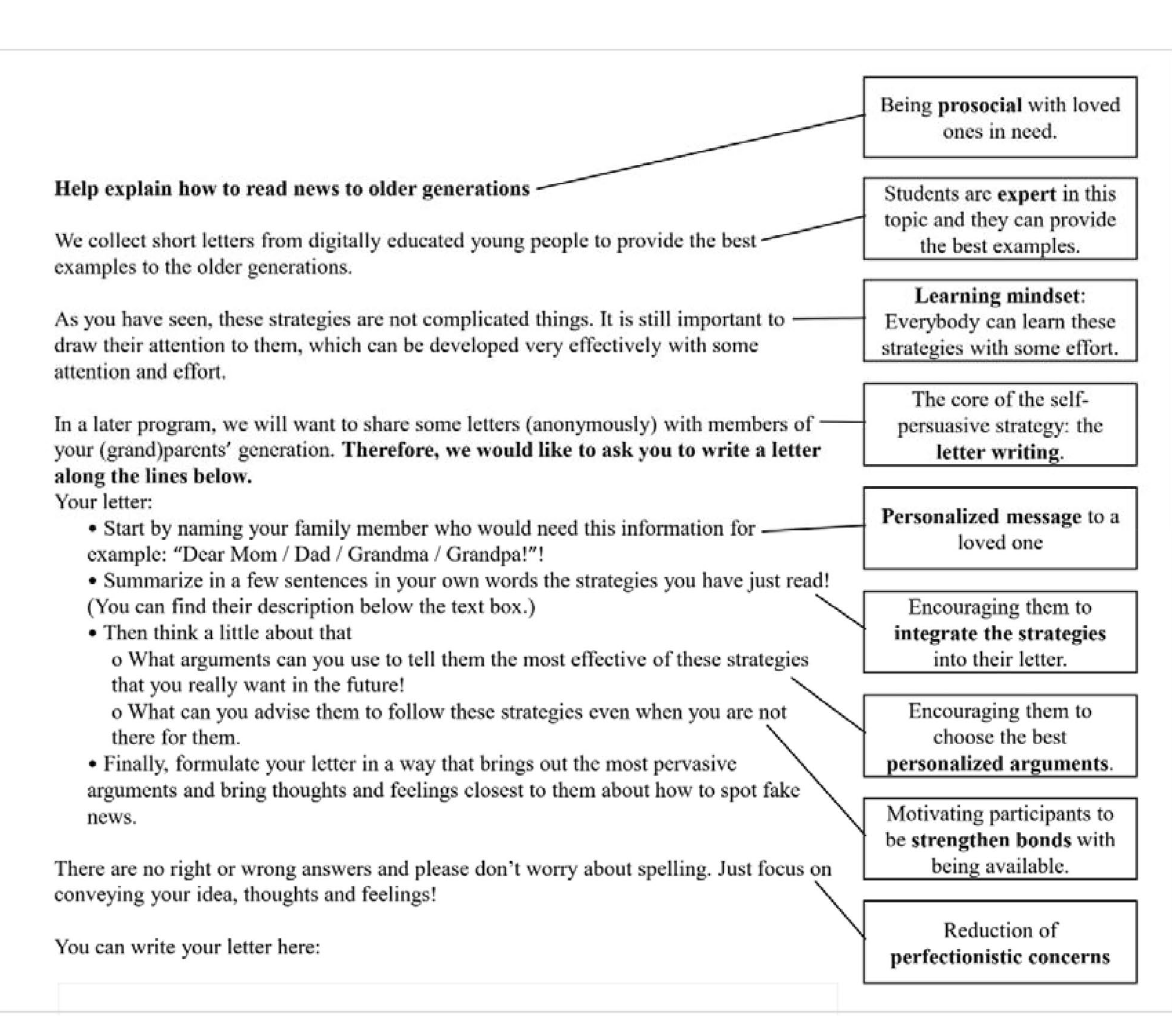
Figure 3. Psychological mechanisms of the self-persuasive message. After reading the six testimonials, participants wrote a letter to a loved one in which they explained the strategies.